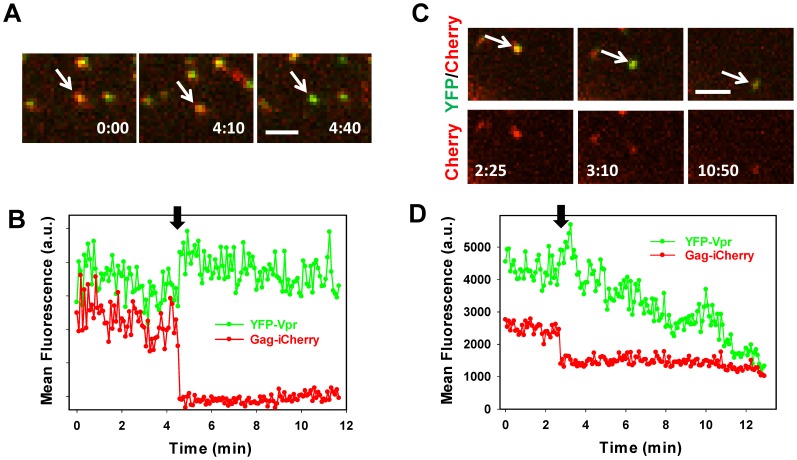
ASLV-A pseudovirus fusion with endosomes results in iCherry release and YFP dequenching.(A, C) Micrographs are showing consecutive snapshots of ASLV-A pseudovirus entry into CV1 cells expressing TVA950. Viruses were co-labeled with HIV-1 Gag-iCherry and YFP-Vpr. The release of viral content (iCherry) into the cytosol is detected by the loss of red signal at t ∼280 s (A, see also movie S2) and ∼250 s (C). The pseudovirus in panel C did not fully release its content, as better seen on the lower image panel showing only the iCherry signal. The time (min:sec) elapsed after raising the temperature is overlaid on all images. Scale bars are 2.5 µm (A) and 3 µm (C). (B, D) The intensity profiles for red (iCherry) and green (YFP) signals from the particles shown in panels A and C were obtained by single particle tracking using the YFP-Vpr channel. In both panels, iCherry release coincides with the stepwise increase in the YFP-Vpr fluorescence. The incomplete release of iCherry and the slow decrease in the YFP signal are apparent in panel D. The YFP signal decay can be caused by YFP-Vpr dissociation from the viral capsid.